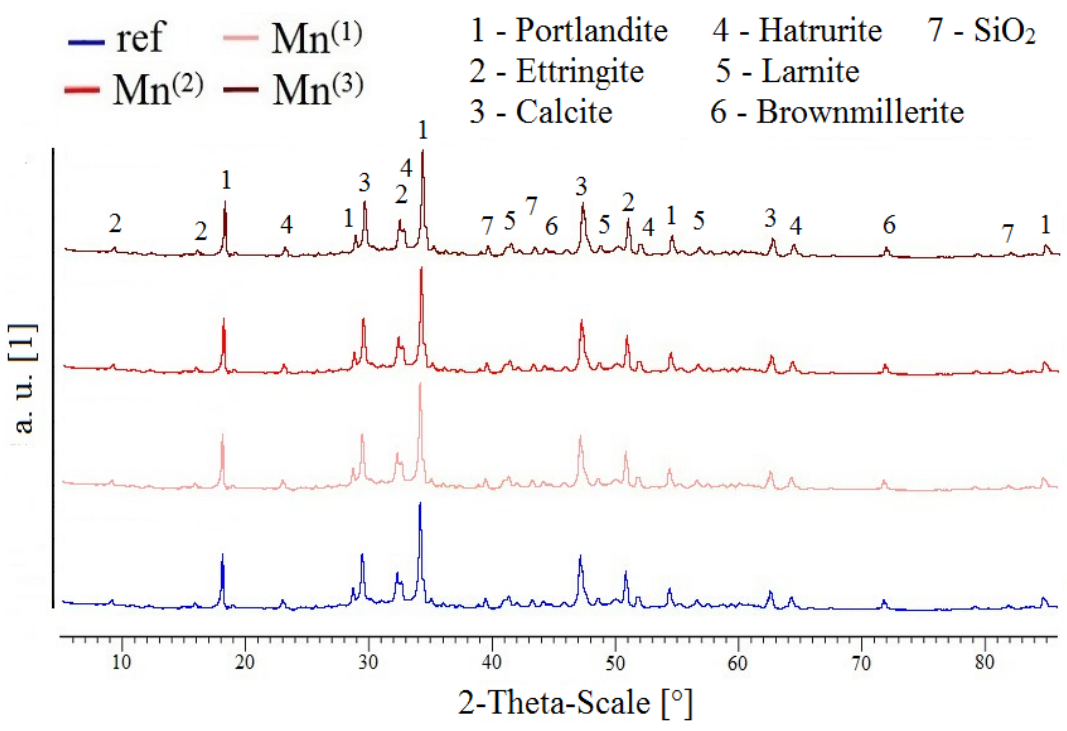
Figure 12. XRD patterns of cement paste samples with different levels of MnO 4 − addition (28 days of curing).